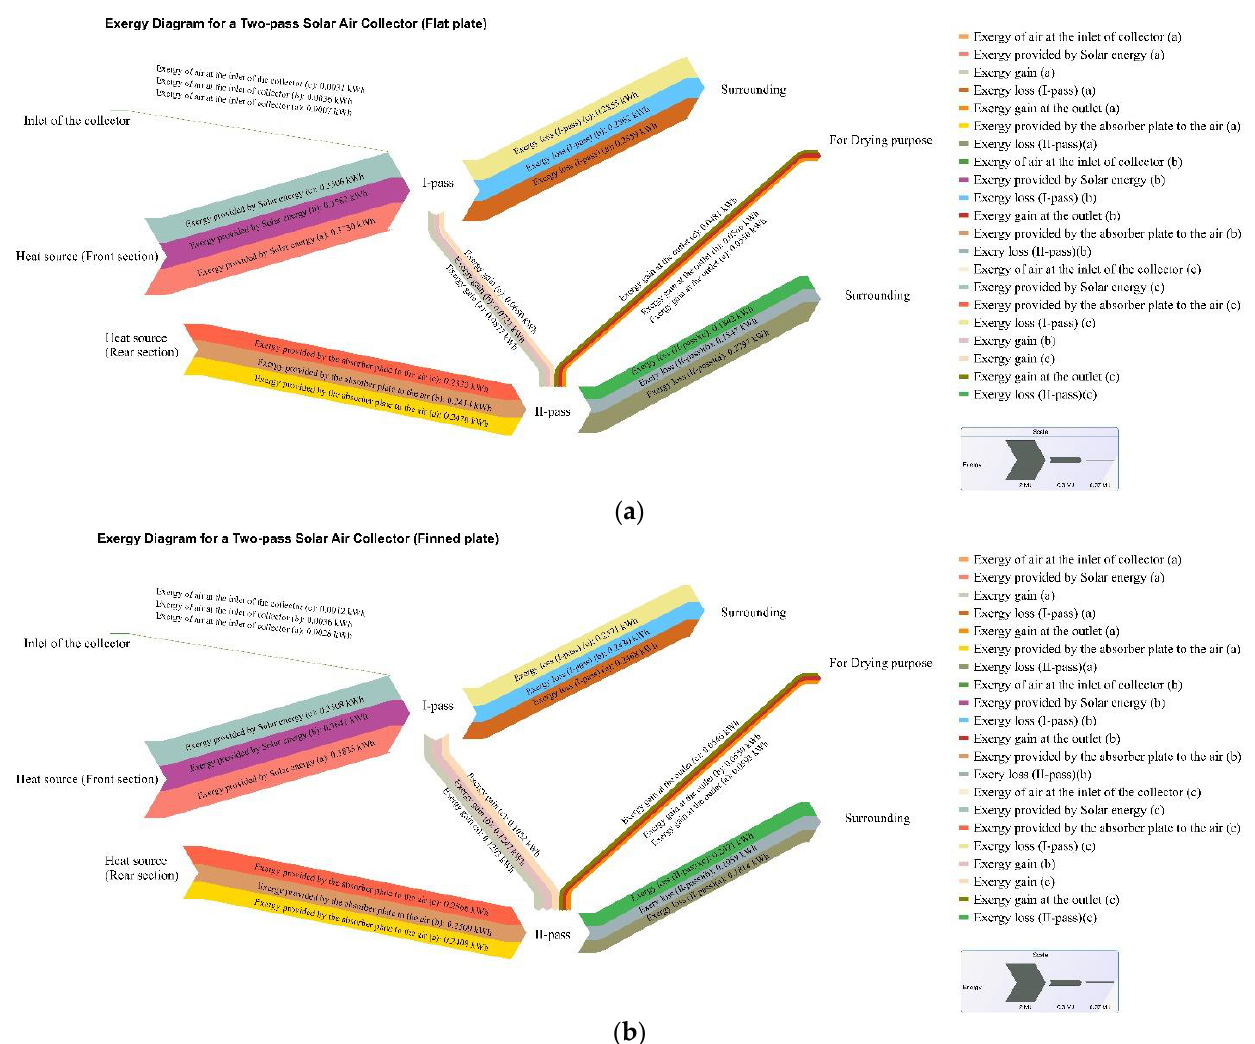
Figure 10. The Grassmann diagram for the two-pass solar air collector (( a ) Collector-I, ( b ) Collector-II) (a: 8.10 g∙s − 1 , b: 10.10 g∙s − 1 , c: 12.10 g∙s − 1 ).